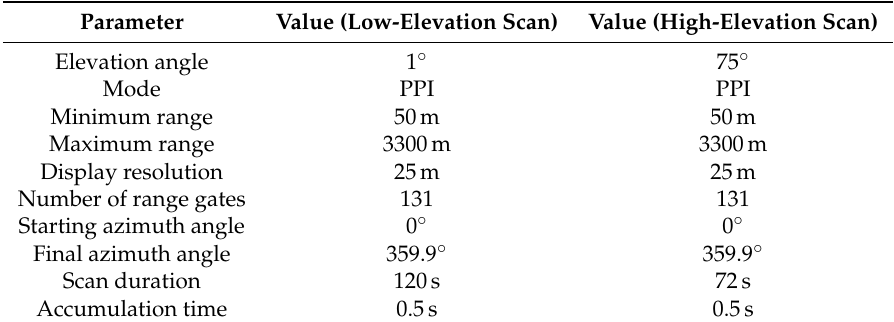
Table 6. Settings for the alternating PPI (plan position indicator) modes for the operation of the Windcube 100s scanning LIDAR (Light Detection and